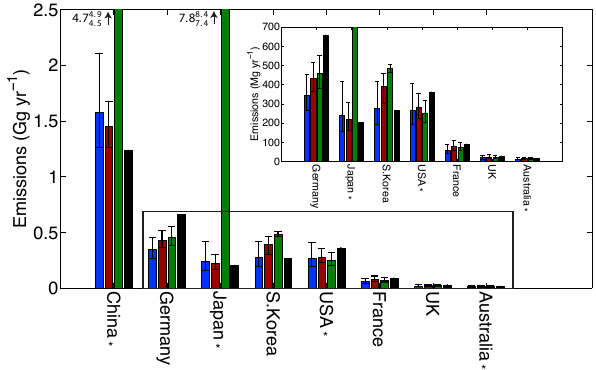
Fig. 4. National emissions derived using three methods: (1) hi- erarchical Bayesian (HB) inversion (blue); (2) non-hierarchical Bayesian inversion (NHB) with model-measurement uncertainties that include a model error (red); and (3) non-hierarchical Bayesian inversion in which no model error was included (green). A priori emissions are shown as black bars, and uncertainties reflect the 16th to 84th percentiles of the posterior national emissions. The asterisk (*) refers to countries in which emissions were derived for only a fraction of the country. For clarity, the inset shows a magnified view of countries with relatively smaller